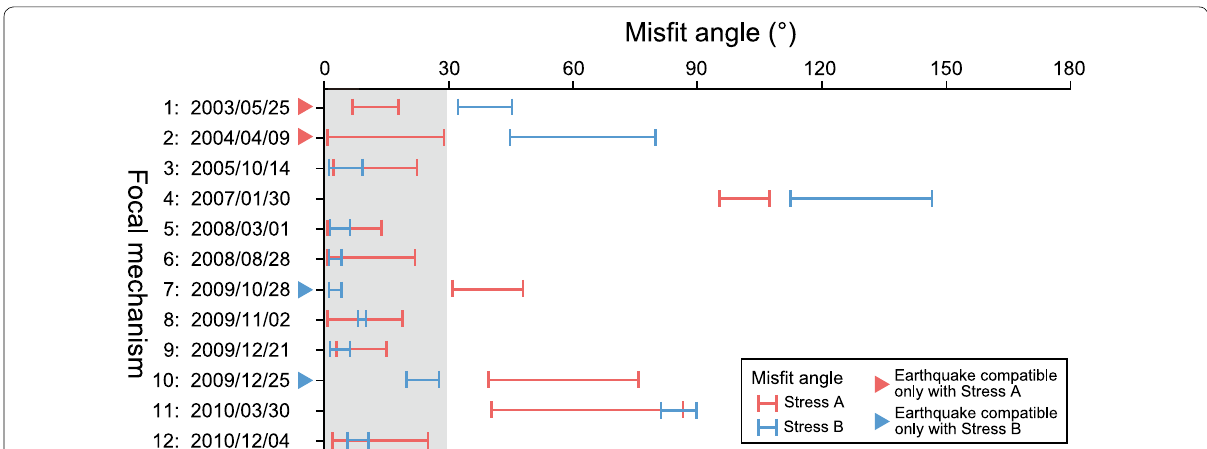
Fig. 3 Misfit angles of the 12 highlighted earthquakes in Fig. 1 for crustal stresses around Iwaki City prior to the 2011 Tohoku earthquake. Red and blue bars indicate the misfit angles for stresses A and B, respectively. A stress with a misfit angle less than 30° (shaded region) is considered compat- ible with a focal mechanism determination (Gephart and Forsyth 1984; Michael 1991). Triangles indicate earthquakes compatible with either stress regime A (red triangles) or stress regime B (blue triangles) based on the approach of Otsubo et al. (2008, 2013). This approach ensures a robust result when based on the misfits of only four